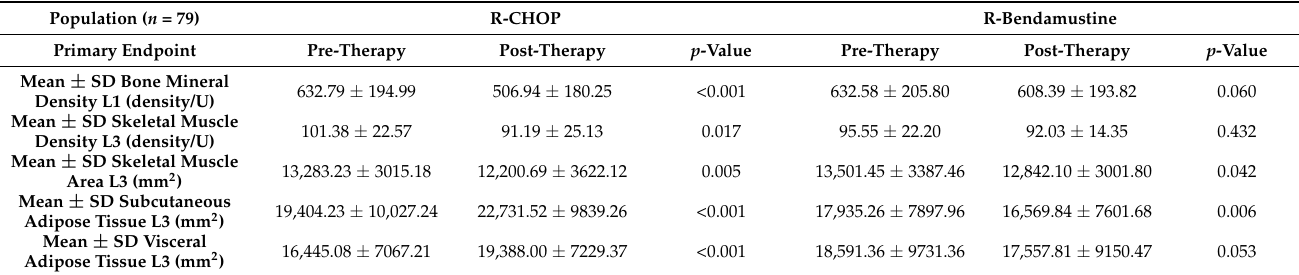
Table 2. Pre–post-therapy radiomic